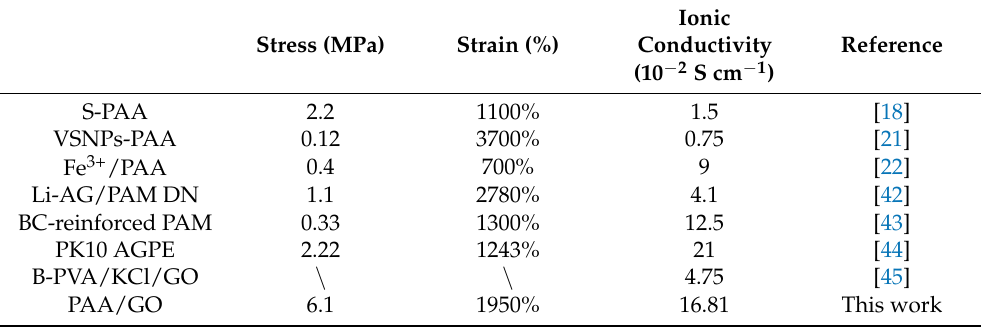
Table A1. Comparison of stress, strain and ionic conductivity of PAA/0.5%GO gel electrolyte in this work with the polymer electrolytes reported in recent